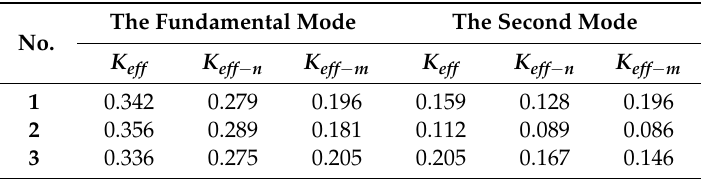
Figure 17. The vibration modes of No. 1 cascaded piezoelectric ultrasonic transducer: ( a ) fundamental mode; ( b ) second mode. Table 4. The theoretical, simulated, and experimental effective electromechanical coupling coefficients of the transducers at the fundamental and second mode.